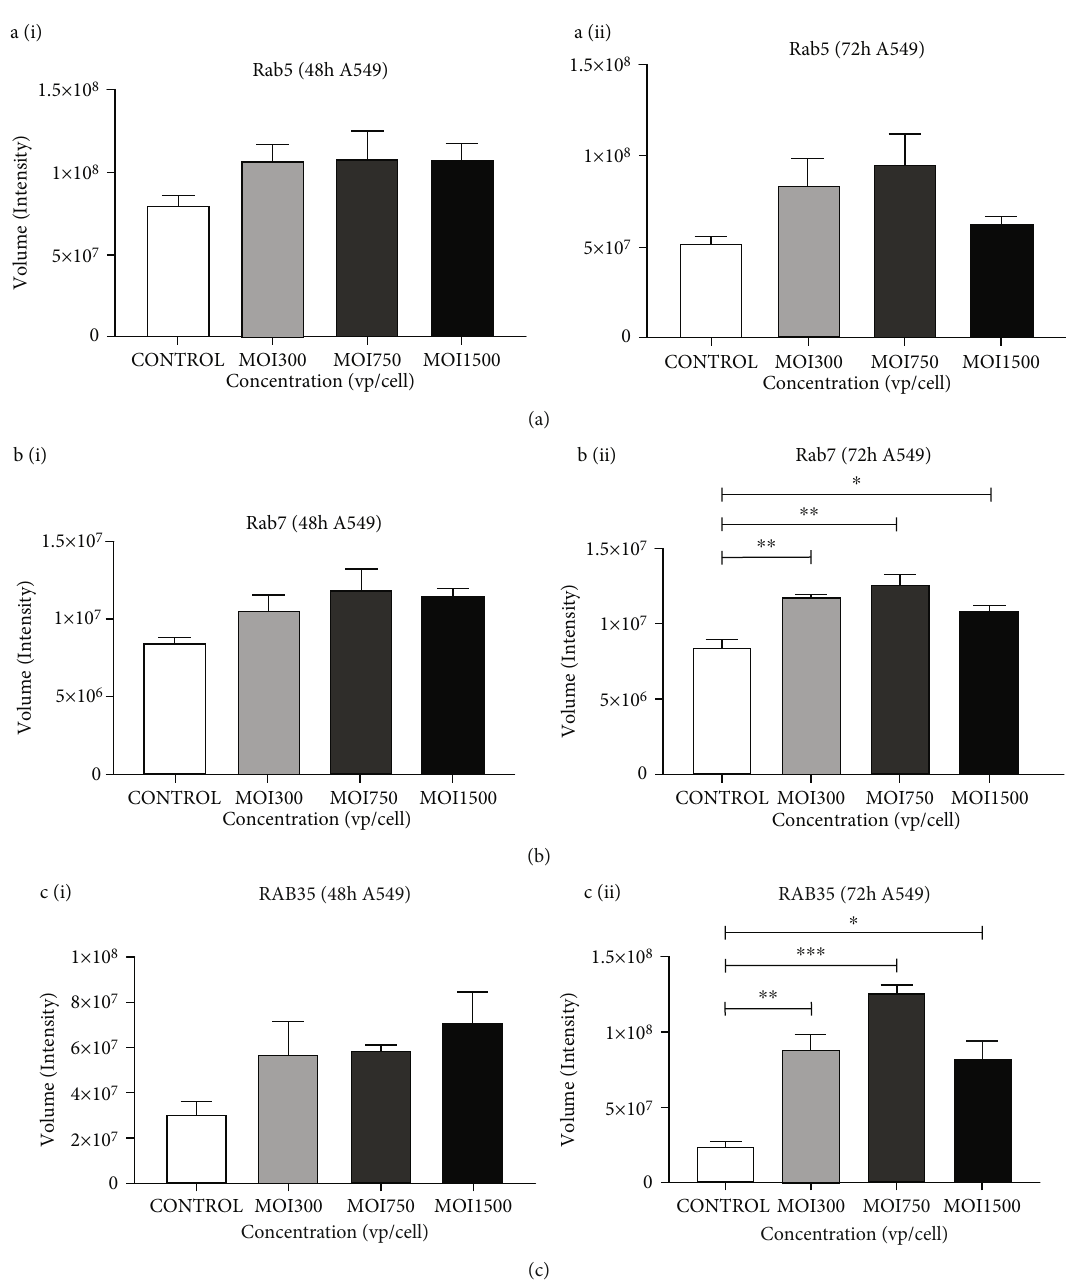
Figure 4: The e ff ect of HAdV3 infection on intracellular tra ffi cking GTPase in A549 lysate. (a) Quanti fi cation of dot blot analysis showing expression of Rab5, Rab7, and Rab35 after 48h and 72h infection. A549 cell lysate was probed for the presence of Rab proteins. (a) (i) Graphs showing quanti fi cation of Rab5 level after 48h and (ii) 72h of infection. (b) (i) Rab7 after 48 h and (ii) 72h of infection. (c) (i) Rab35 after 48h and (ii) 72 h of infection. Dots shown in the fi gure are representative of four independent experiments. Data shows the mean ± SEM from four independent experiments and performed using one-way analysis of variance (ANOVA) with Tukey post hoc analysis. Statistical signi fi cance is indicated by the mean ± SD as follows: ∗ p < 0 : 05 , ∗∗ p < 0 : 01 , ∗∗∗ p < 0 : 001 , and ∗∗∗∗ p < 0 : 0001